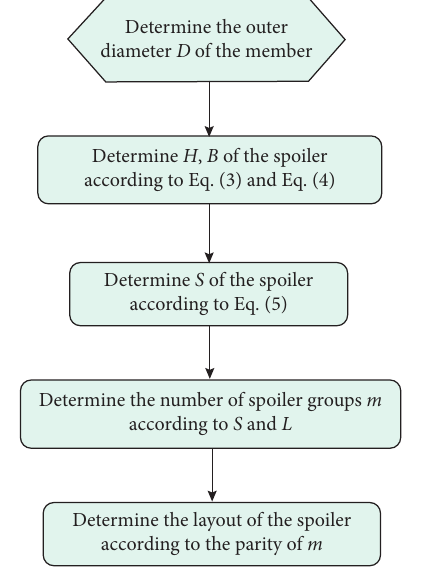
Figure 14: Design process of the proposed